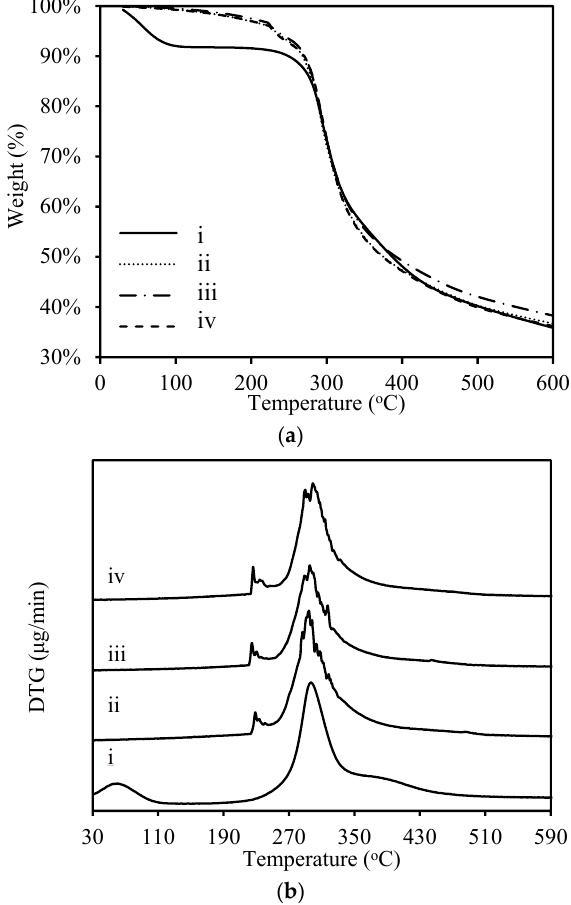
Figure 6. Thermogravimetric analysis (TGA) ( a ) and difference thermo gravimetry (DTG) ( b ) of the RS powder, the original RS resins, and the RS hot-rolled resin with 50% reduction ratio, (i. RS powder; ii. RS original resin; iii. RS hot-rolled resin without treatment; iv. RS hot-rolled resin with boiling treatment).